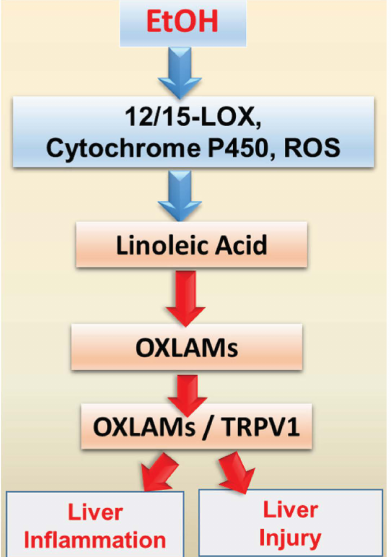
Figure 3. Proposed model of OXLAM/TRPV1-mediated mechanism of USF and EtOH-mediated liver injury and inflammation. Abbreviations: EtOH: ethanol; LOX: lypoxygenase; ROS: reactive oxygen species; OXLAMs: oxidized linoleic metabolites; TRPV1: Transient Receptor Potential Vanilloid